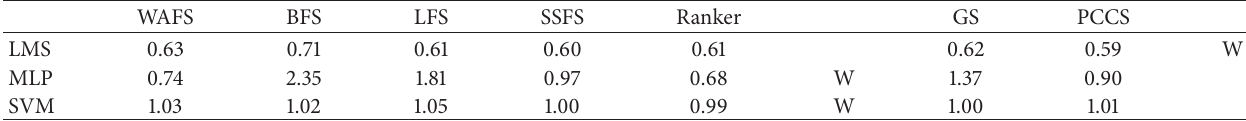
Table 5: Achieved MASE after applying various wrapper selection methods on LMS, MLP, and SVM. WAFS BFS